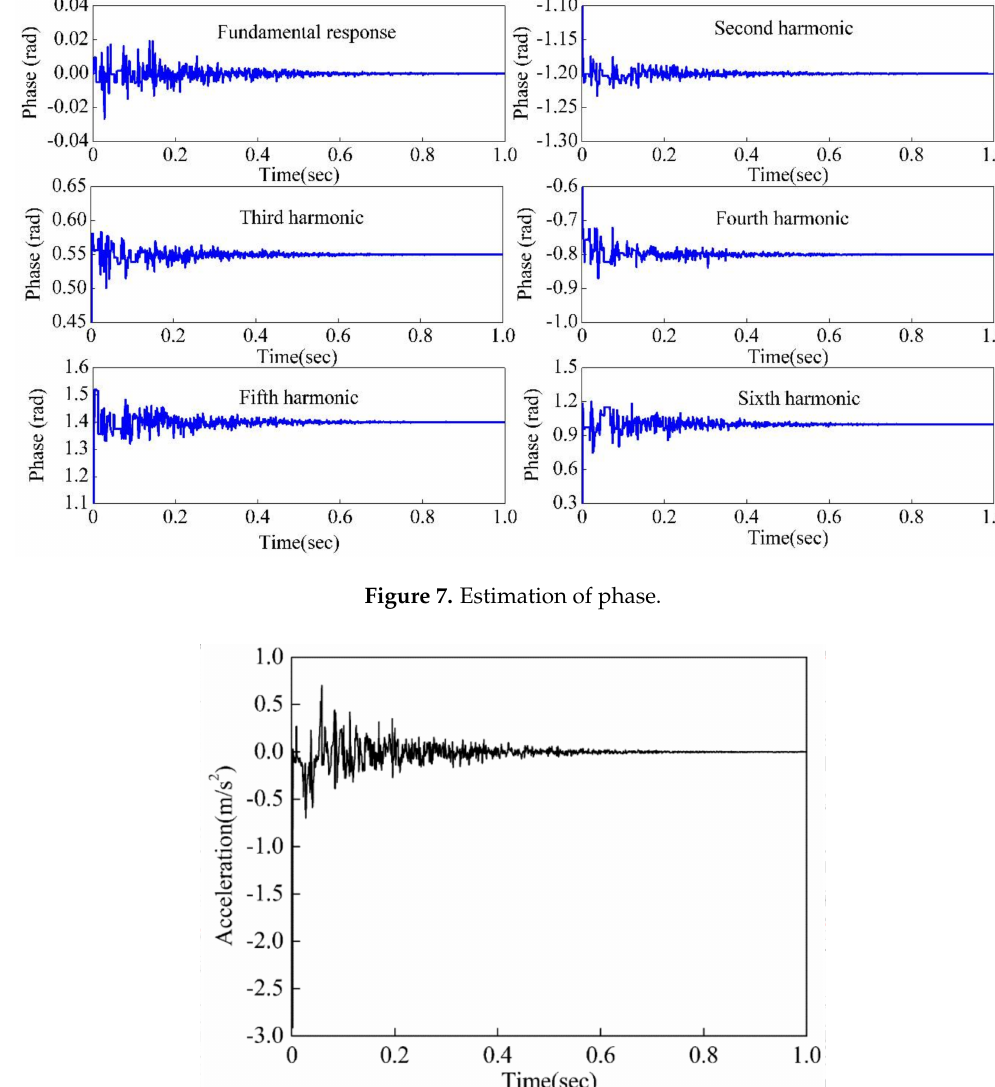
Figure 8. Estimation of